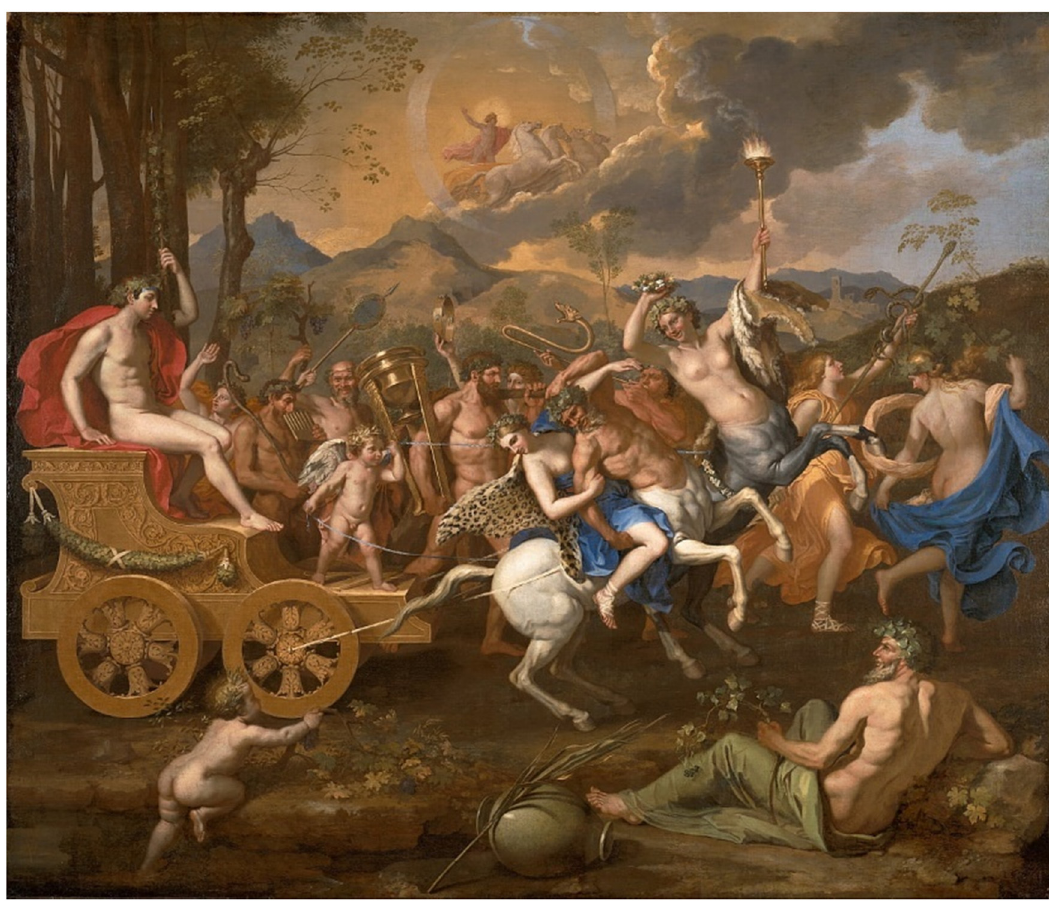
Figure 23: Nicolas Poussin, The Triumph of Bacchus , Ca. 1630. The Nelson - Atkins Museum of Art, Kansas City.